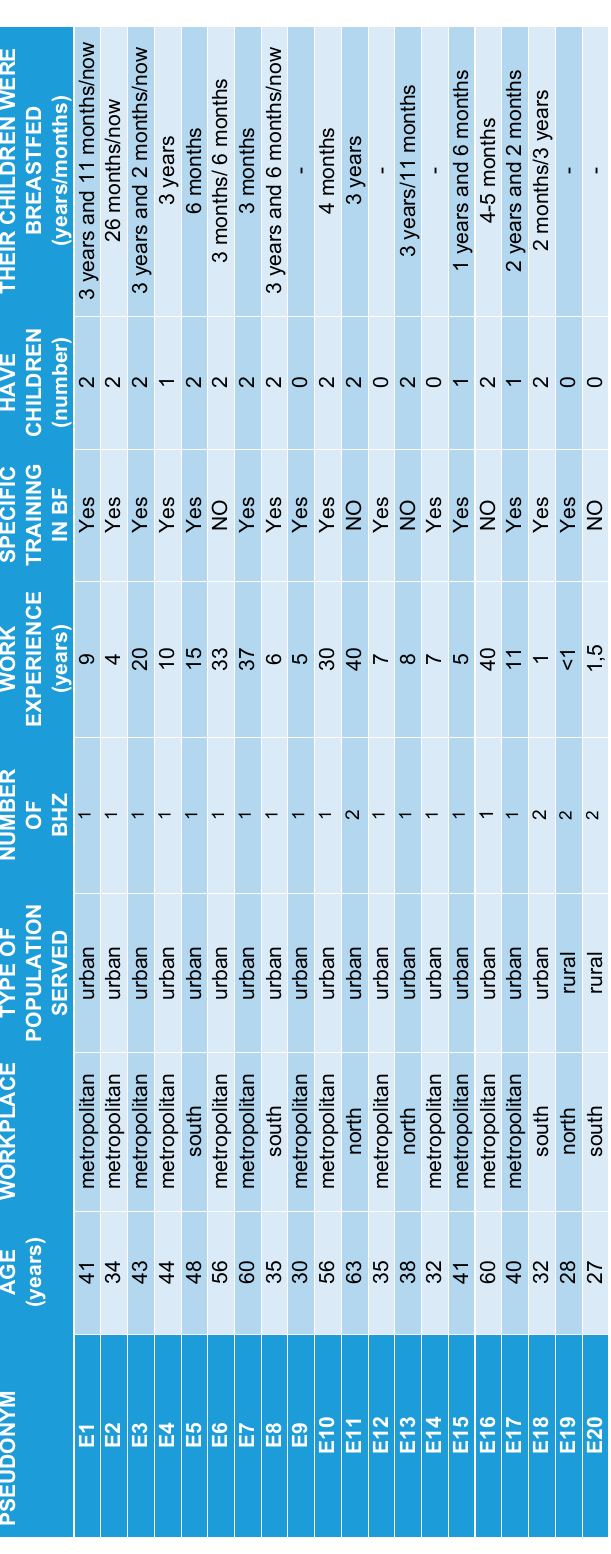
Figure A1. Profiles Primary Care Midwives.